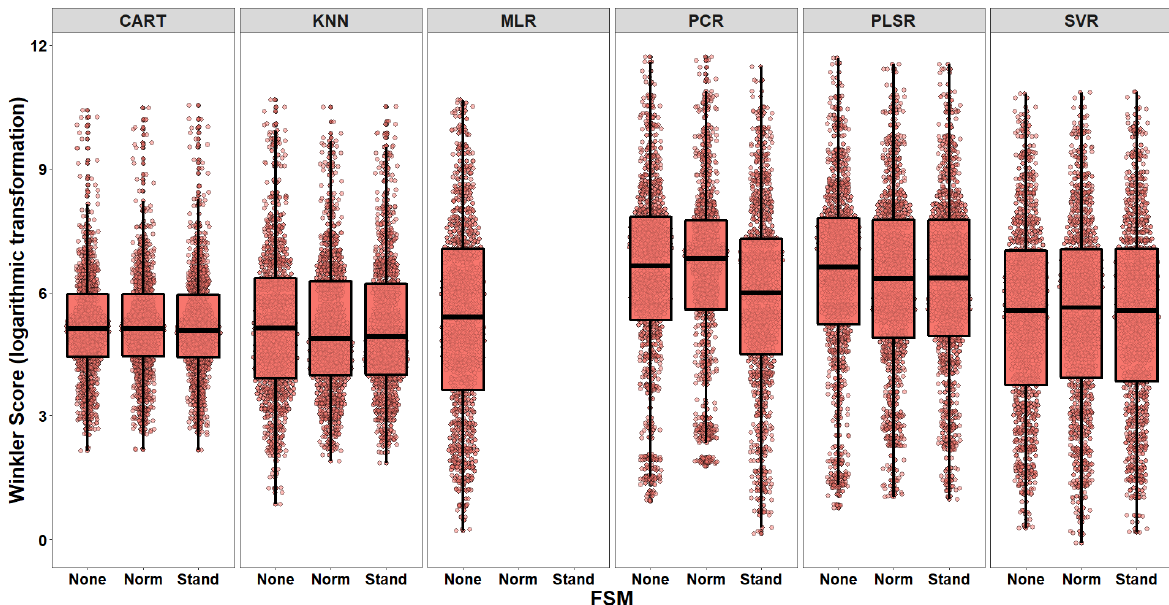
Figure 8. Boxplots of WS distributions (log-transformed scale) for each model (combination of algorithm and FSM).